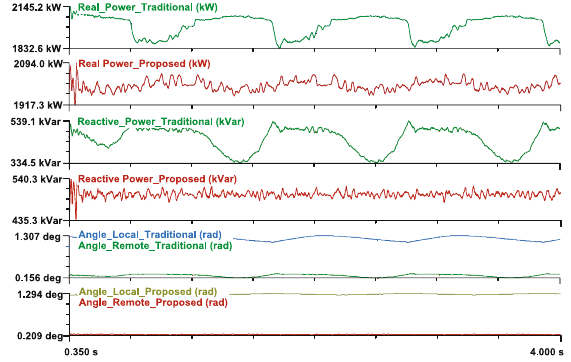
Fig. 23 Output of the CIG during disturbances with the traditional local information based and the proposed DSE based control scheme